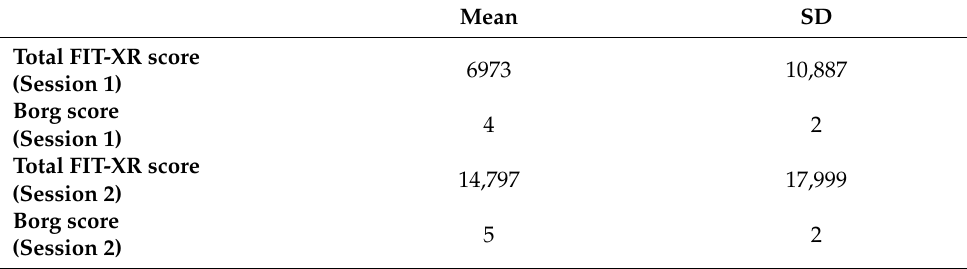
Table 3. Total scores (FIT-XR and perceived effort) for each session.